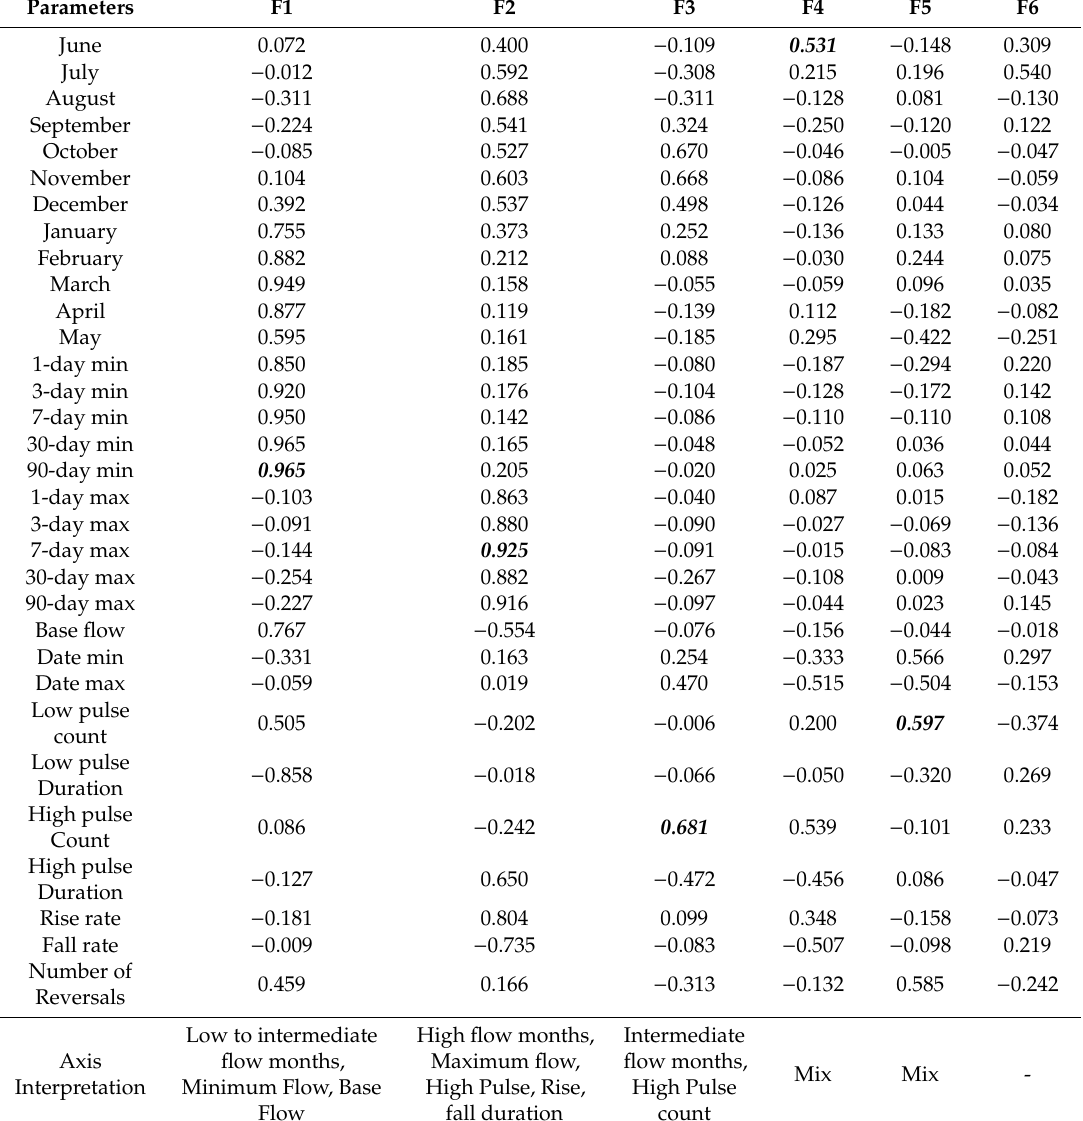
Table 4. Loadings for first Six PCs in Spearman’s